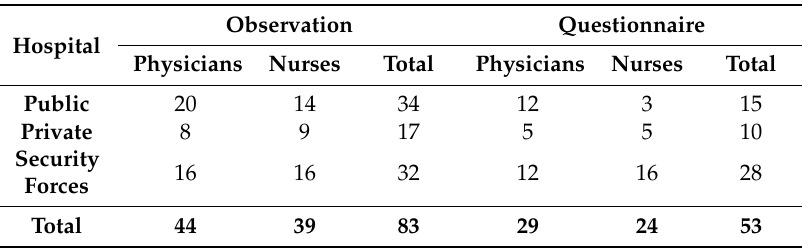
Table 1. Participant